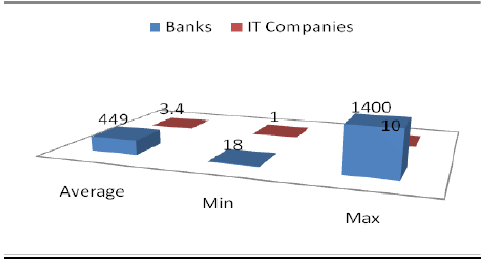
Figure 3: Number of Office